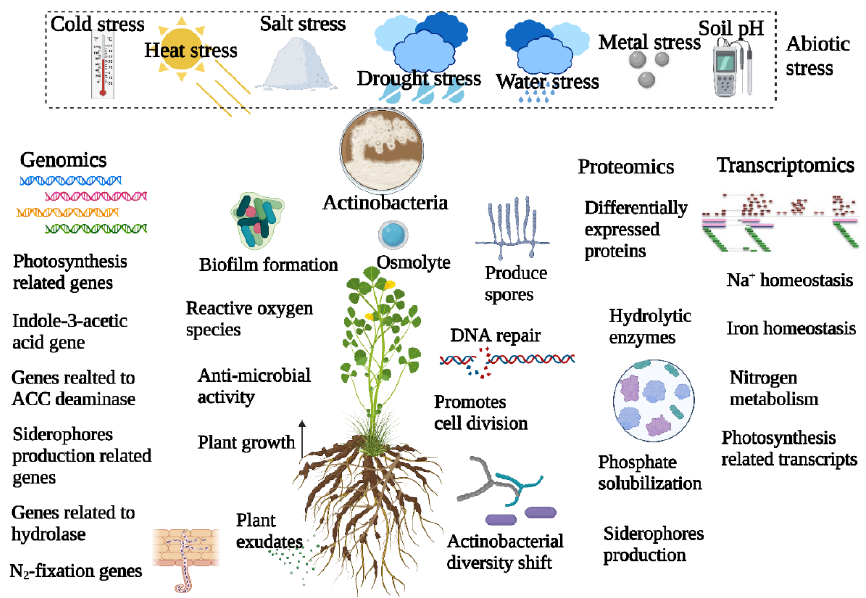
Figure 2. Actinobacteria-mediated abiotic stress mitigation in plants. The effect of abiotic stress on actinobacteria–plant interaction was evaluated by various omics approaches.